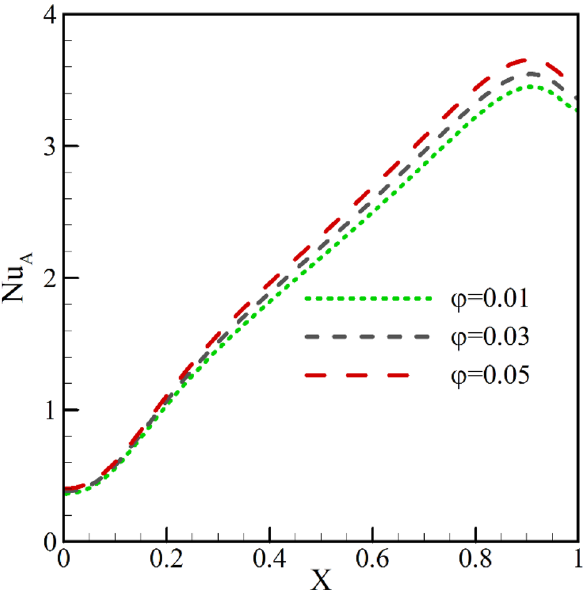
Figure 7. The average Nu for different volume fractions in the absence of radiation at φ = 0.3, λ = 0°, Ra = 10 5 , γ = 45°, Ha = 20.